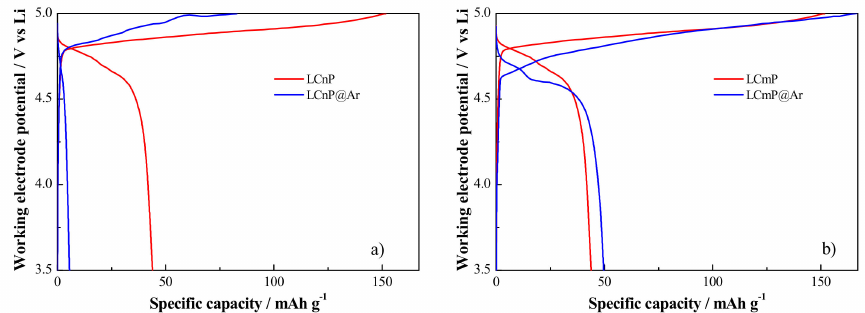
Figure 7. Cell voltage profile in galvanostatic conditions of the ( a ) Ni- substituted and ( b ) Mn-substituted samples before and after the annealing under